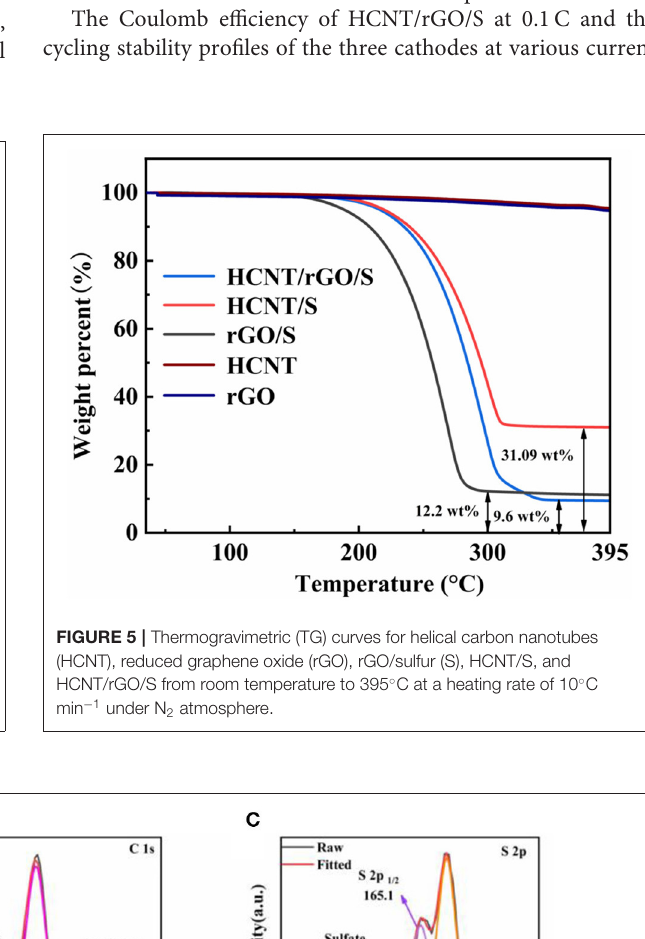
Frontiers in Energy Research |